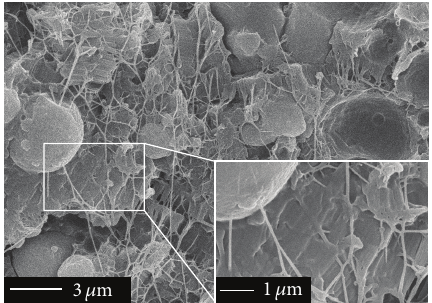
Figure 5: SEM image of the microstructure of unreacted